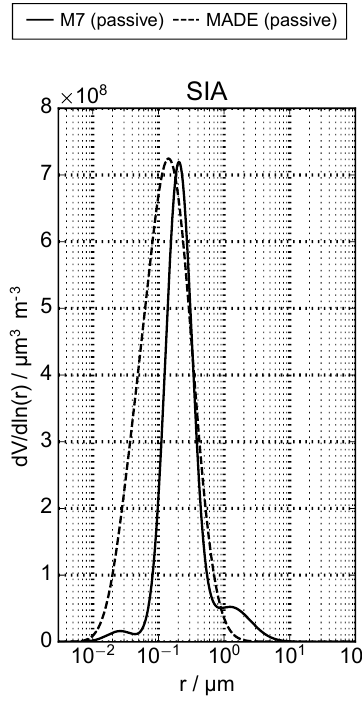
Figure 7. Domain-averaged volume distributions of SIA for default setups. This figure corresponds to SO 4 in Fig. 5 but shows SIA for the Passive simulations. SIA corresponds to SO 4 for M7 and addi- tionally includes NO 3 and NH 4 for